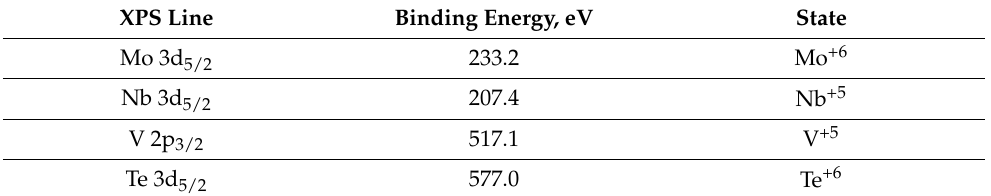
Table 2. Binding energies and oxidation states of the elements in the MoVTeNbO catalyst.